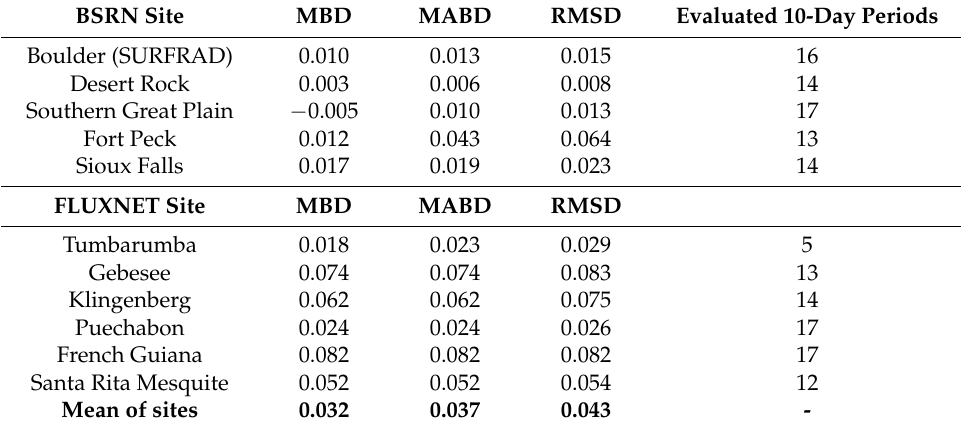
Table 4. The evaluation metrics for the BSRN and FLUXNET